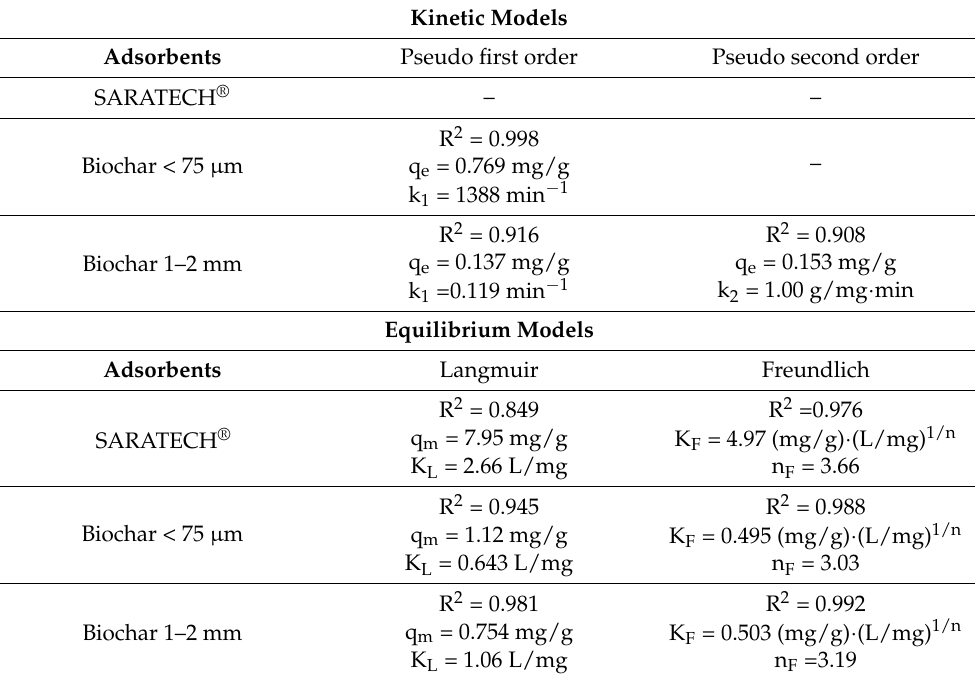
Table 4. Parameters for the kinetic and isotherm